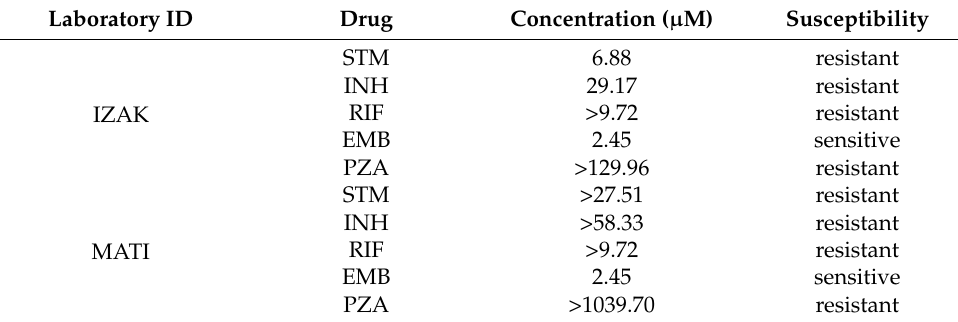
Table 4. Susceptibility profiles of tested MDR Mtb